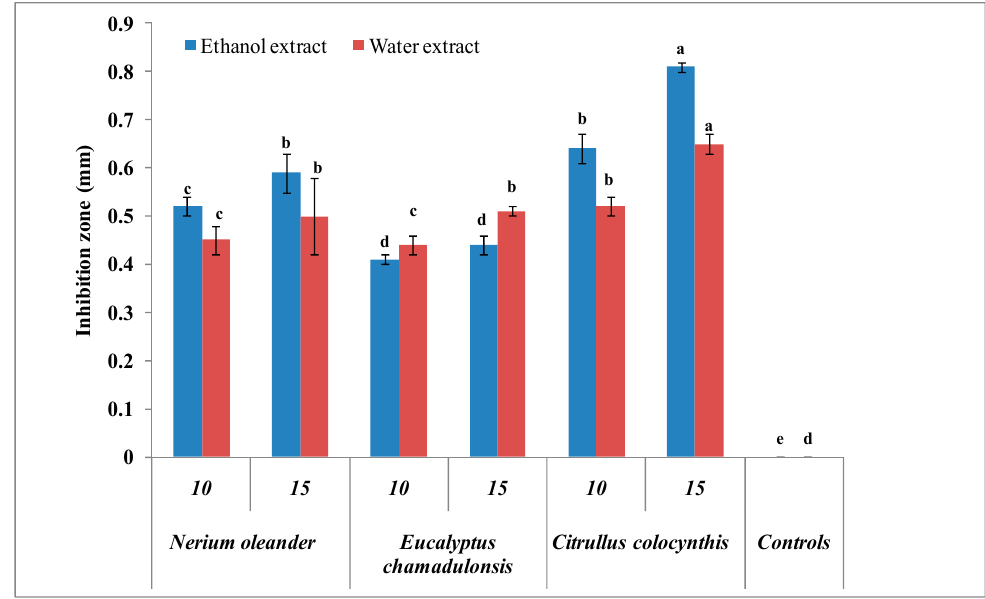
Figure 1. Antibacterial activity of 10% and 15% concentrations of plant extracts of Nerium oleander , Eucalyptus chamadulonsis and Citrullus colocynthis against Xanthomonas axonopodis pv. vesicatoria PHYXV3 in vitro after 48 h of incubation at 27 ° C . Four replicate plates were used for each treatment and the experiment was repeated twice. Columns with the same letters are not significantly different according to Fisher’s protected least significant difference at p ≤ 0.05.